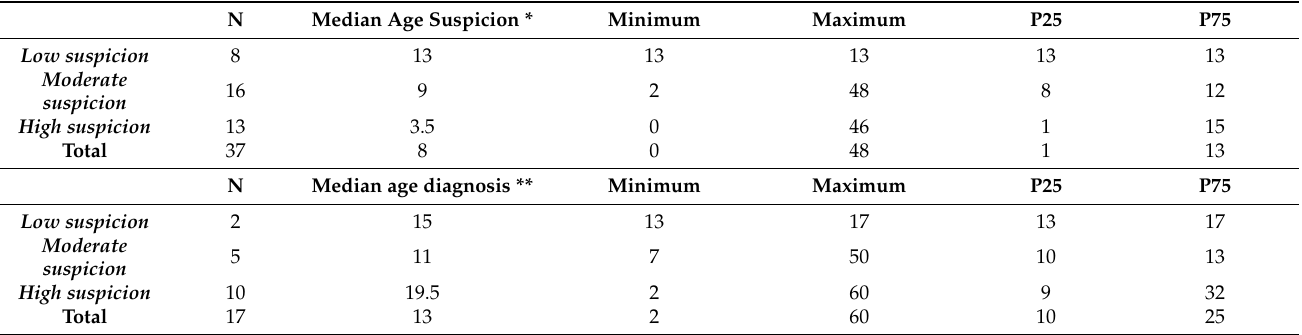
Table 2. The median age of individuals at suspicion and confirmed diagnosis, separated by degree of clinical suspicion for primary ciliary